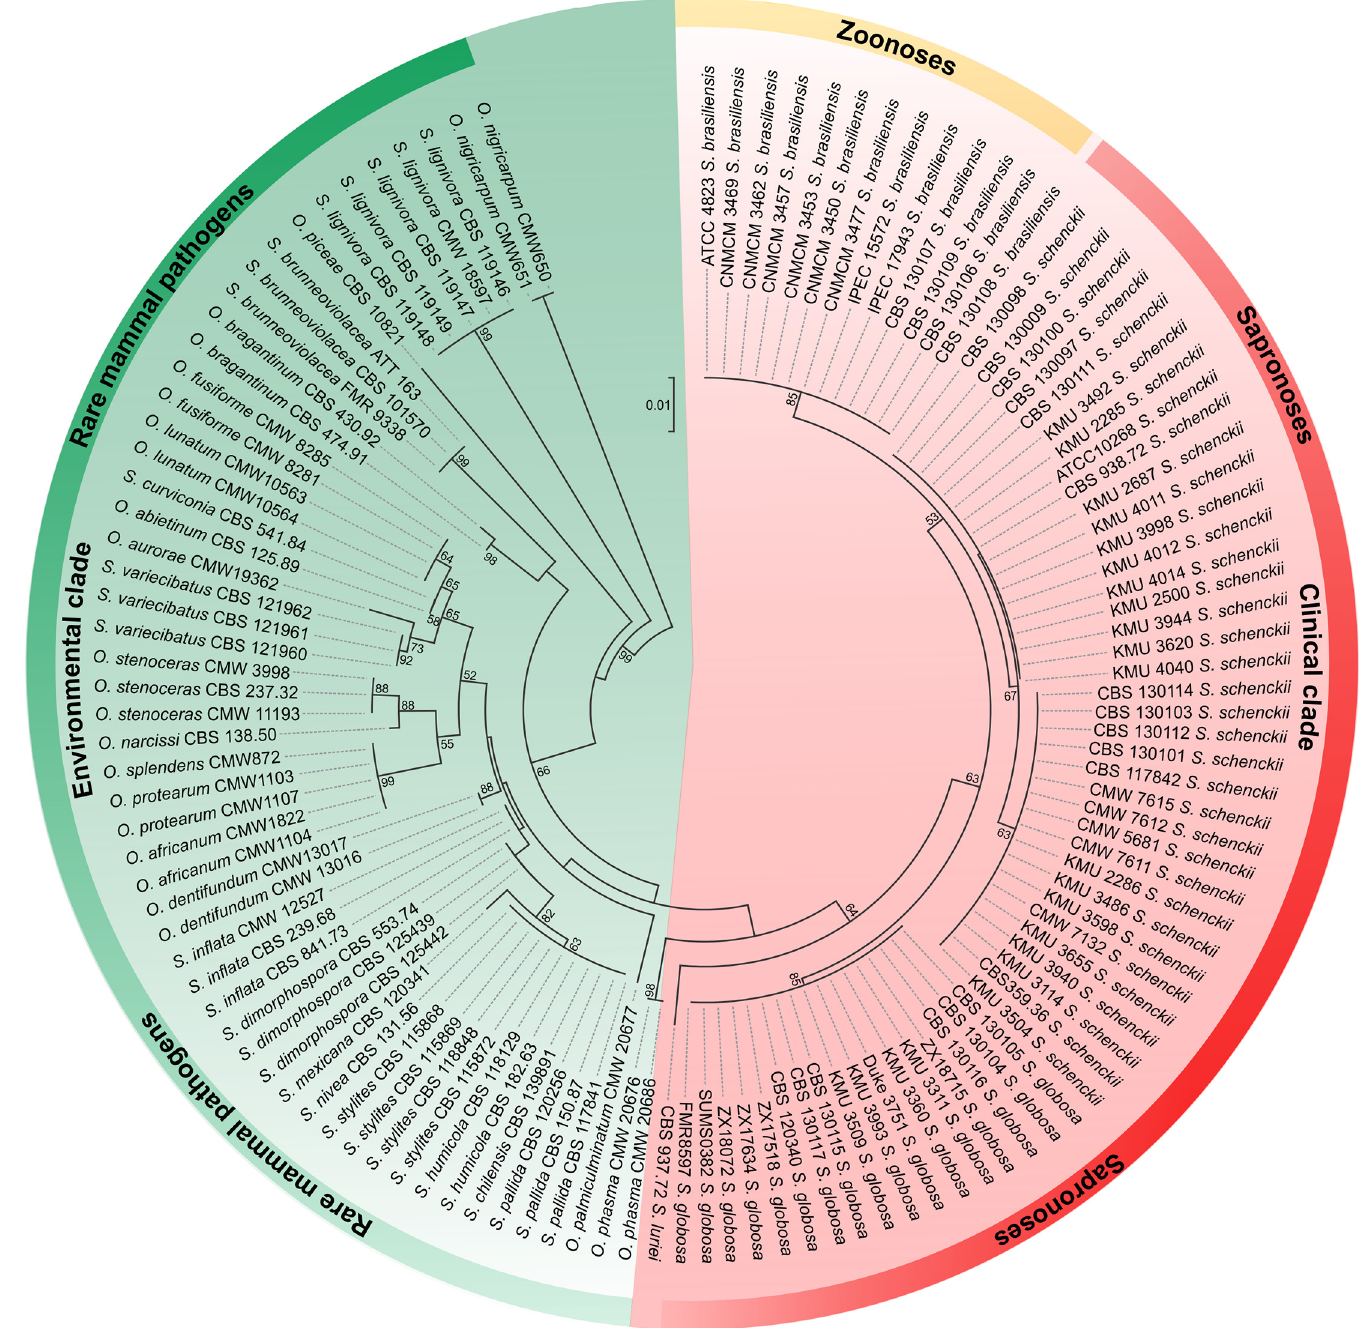
Fig 1. Phylogenetic analyses correlate with ecological behavior of Sporothrix species. Comparing the clades over the entire tree reveals a consistent decrease of bark beetle and soil association outside Ophiostoma , with a concomitant increase of vertebrate infectivity in S . brasiliensis , S . schenckii , and S . globosa . Phylogenetic tree generated by neighbor-joining analysis using partial nucleotide sequences of the rDNA operon (ITS1+5.8s+ITS2). Bootstrap value (1,000 replicates) was added to respective branches. Each species is indicated at its respective position in the phylogenetic tree. Bar = total nucleotide differences between